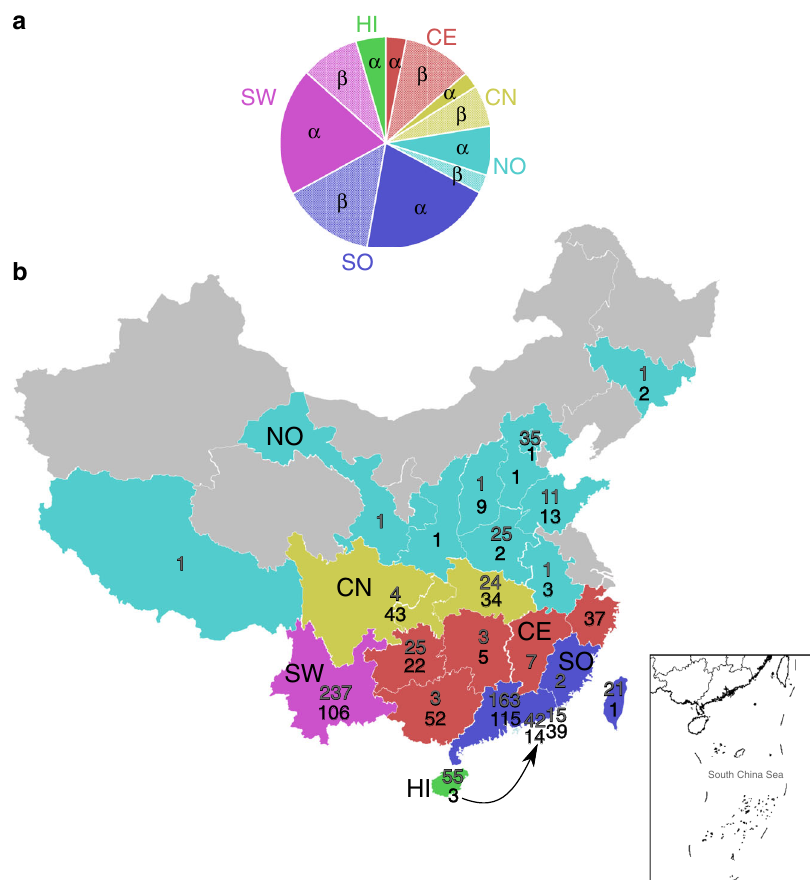
Fig. 1 Geographic sampling. Pie chart ( a ) showing the number of sequences of each CoV genus ( α -CoVs and β -CoVs) available for each zoogeographic region and map of China provinces ( b ) showing the number of RdRp sequences available for each province, in bold gray for α -CoVs and black for β -CoVs. Province colors correspond to the zoogeographic region to which they belong: NO Northern region, CN Central northern region, SW South western region, CE Central region, SO Southern region, HI Hainan island. The three β -CoV sequences from HI were included in the SO region. Provinces colored in gray are those where CoV sequences are not